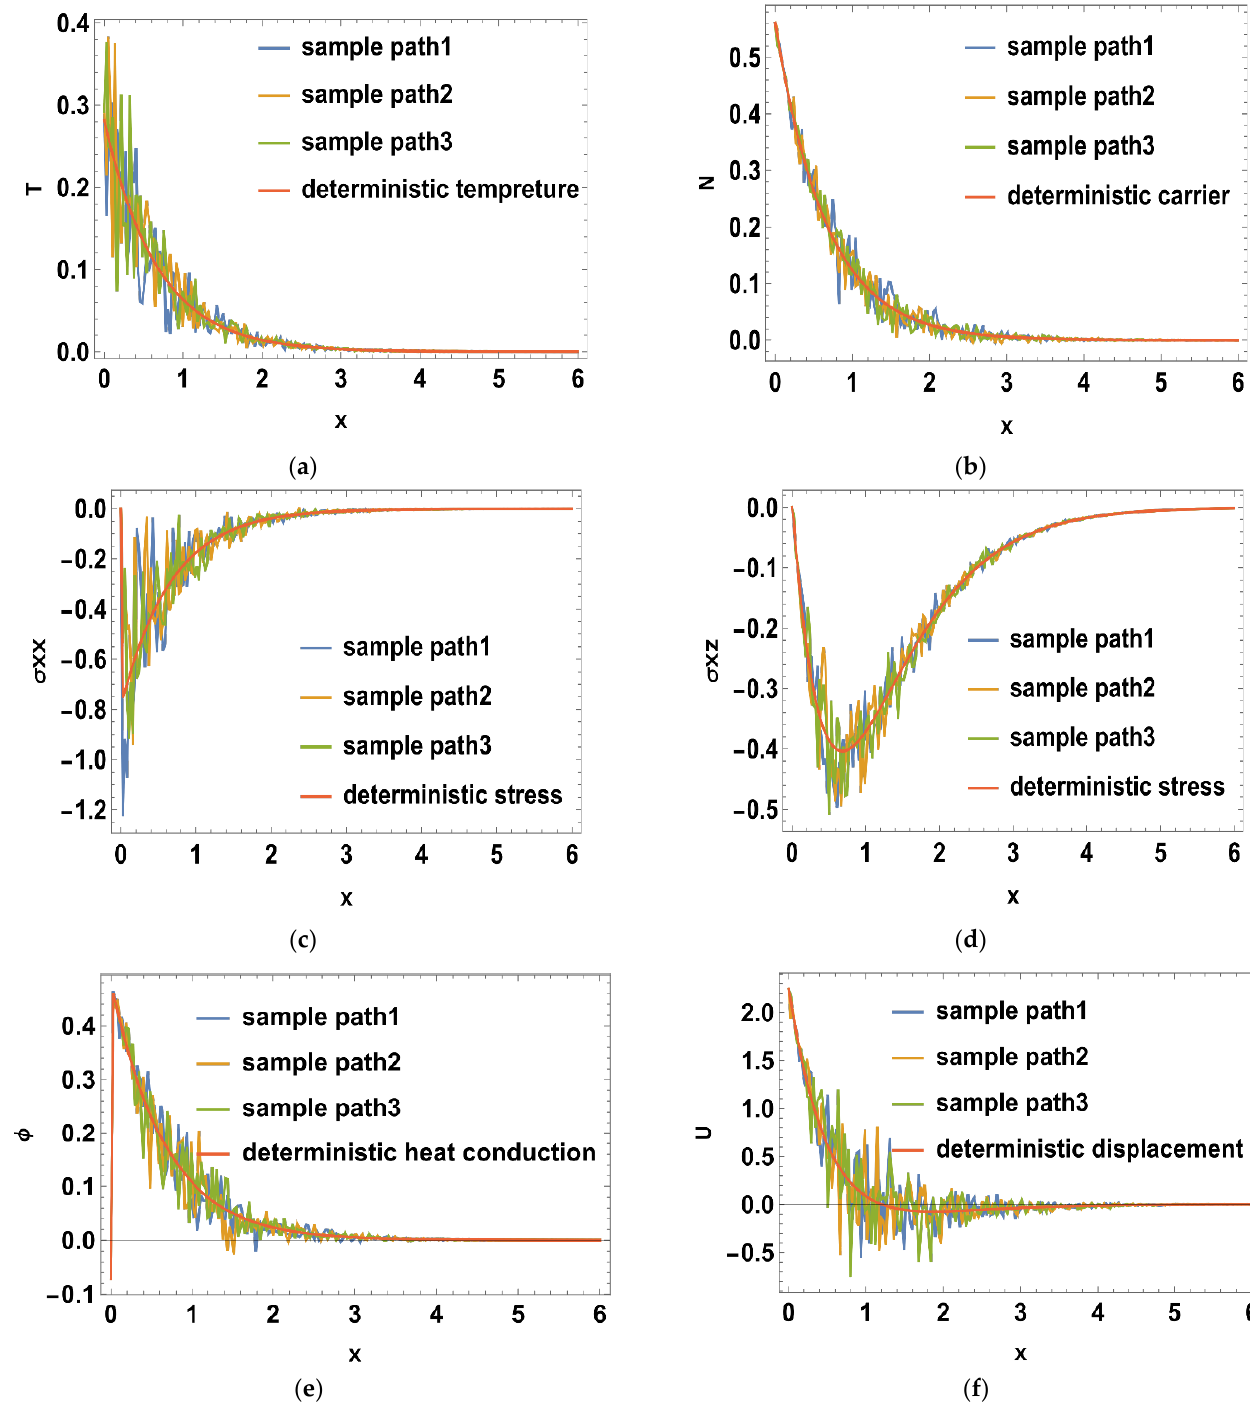
Figure 5. ( a – f ) The deterministic and stochastic distributions of temperature, normal stress, carrier density, displacement and heat conduction distributions along the distance at t = 0.4 in relation to generalized photo-thermoelasticity theory, when 0 a = .